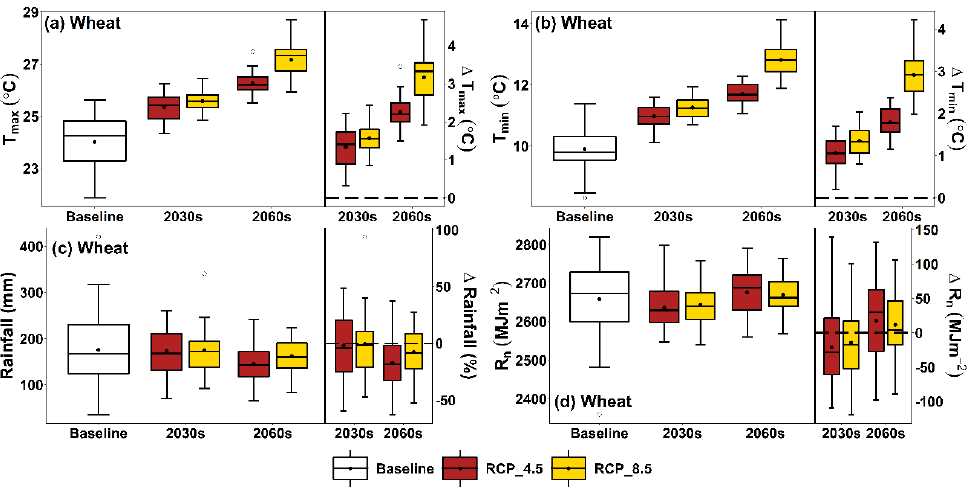
Figure 2. Wheat seasonal (November–April) average ( a ) maximum temperature (T max ), ( b ) minimum temperature (T min ), and ( c ) seasonal cumulative rainfall (P), as well as the ( d ) solar radiation (R n ) during the baseline (1980–2010), 2030s (2021–2050), and 2060s (2051–2080). The box in Figure 2 and hereafter represents the interquartile range (IQR). The whiskers extend up to 1.5 times the IQR, and the hollow dot outside the box represents the